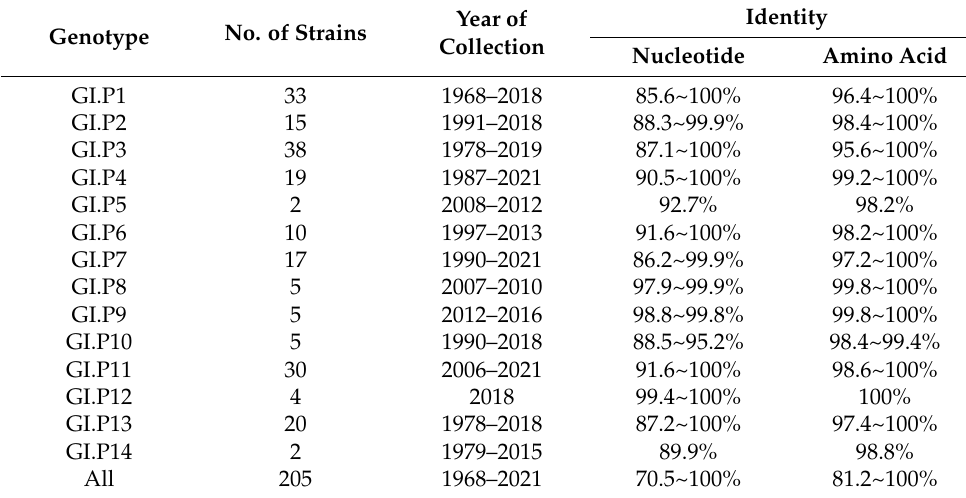
Table 1. Summary and identity of norovirus GI RdRp strains in this study. Genotype